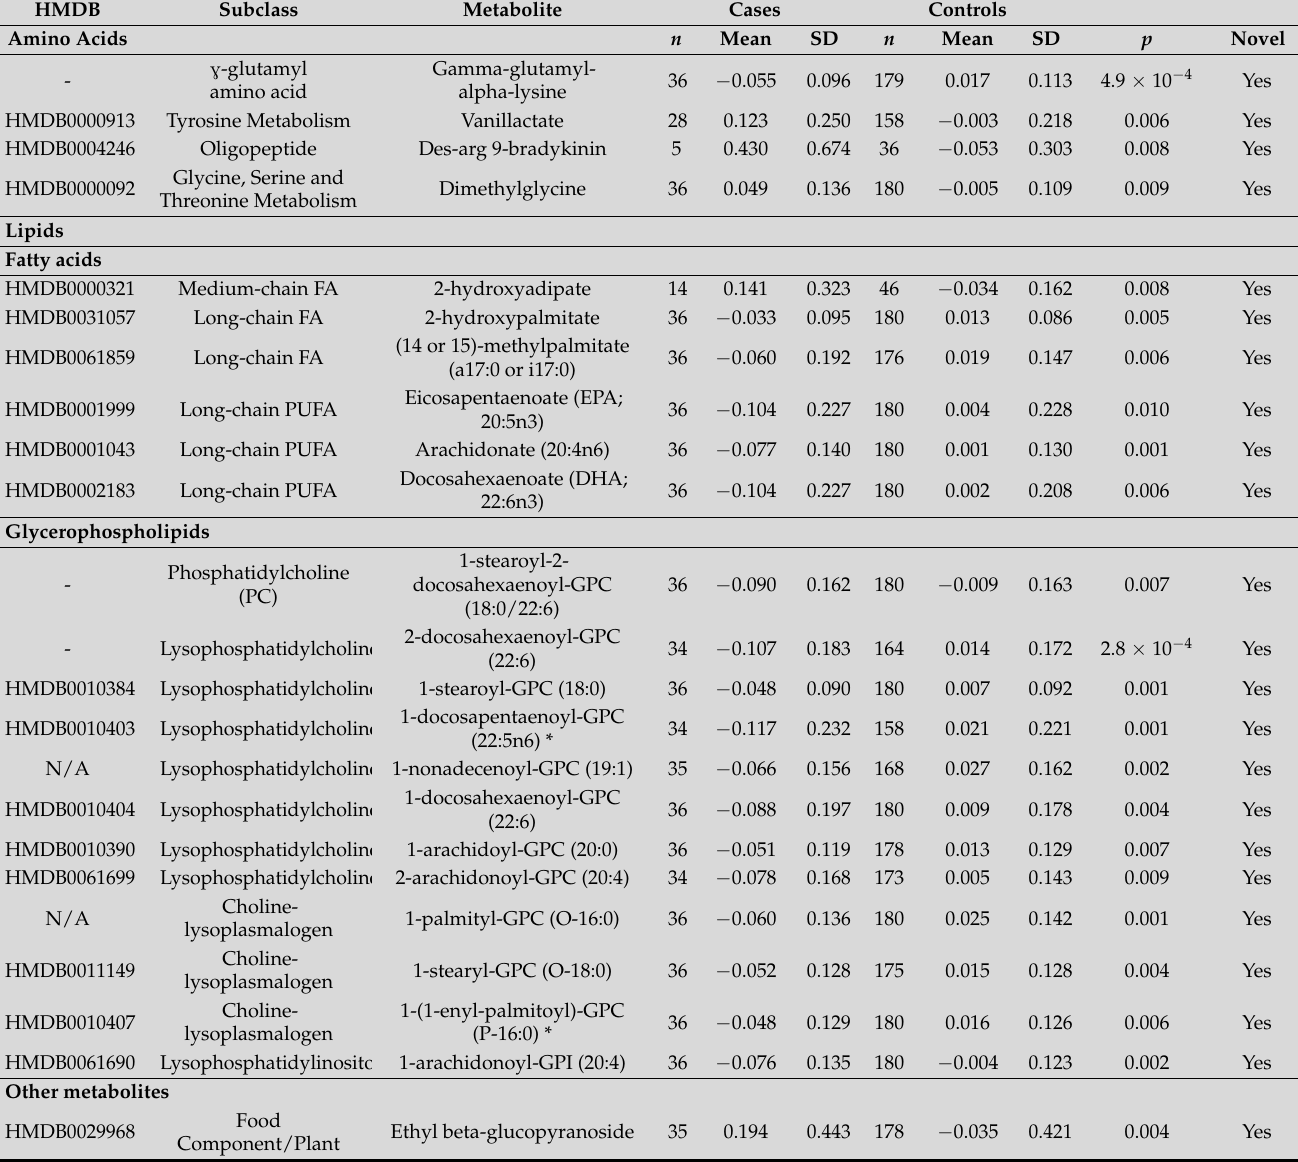
Table 3. Statistically significant differences in metabolite concentrations between the carriers (Cases) and non-carriers (Controls) of the pathogenic or likely pathogenic HCM